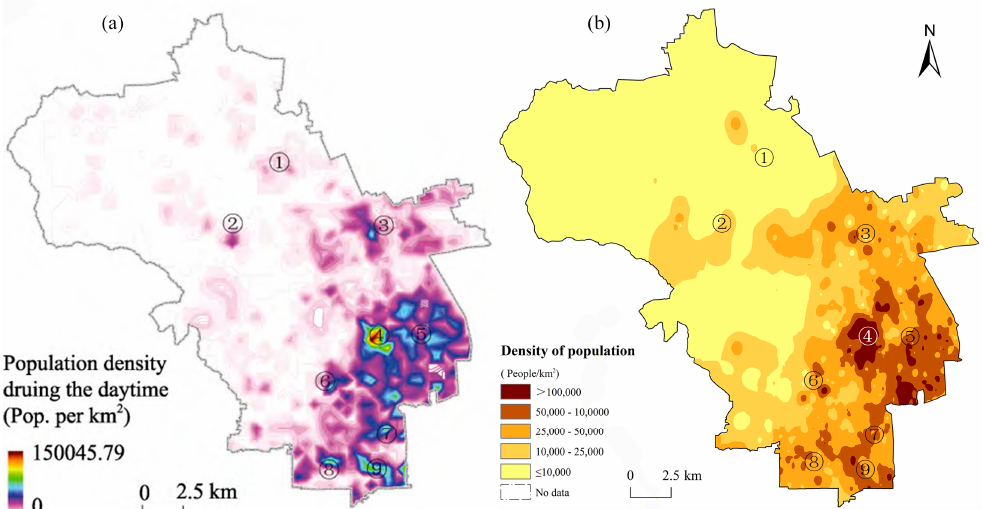
Figure 7. Comparison of the results of the daytime population distribution between the ( a ) methods of reference [24]; and ( b ) this paper. 1, Yongfeng High-tech Industrial Base; 2, Wenquan Science & Technology Park; 3, Shangdi Information Industry Park; 4, Zhongguancun; 5, University area; 6, Shijicheng; 7, Ganjiakou; 8, Wukesong; 9, Gongzhufen.